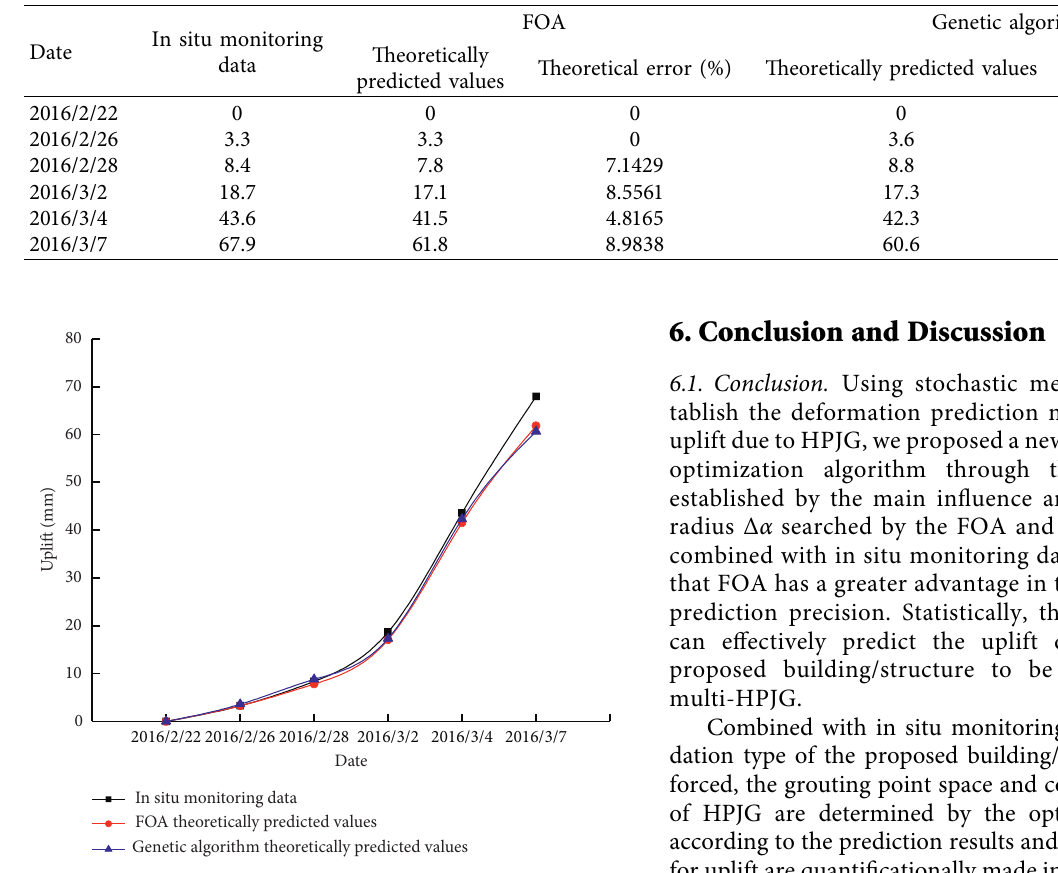
Figure 11: Comparison of the predicted uplift effect of HPJG and in situ monitoring